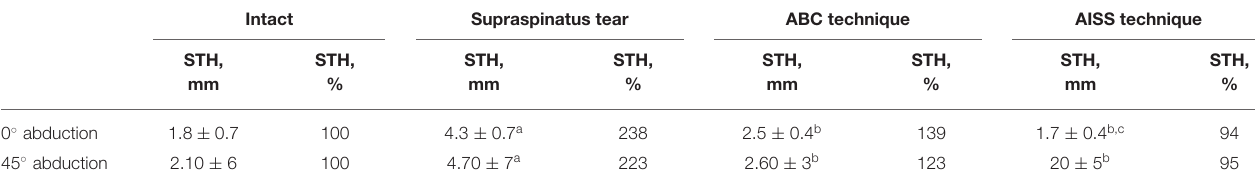
TABLE 1 | Superior translation of the humerus (STH).